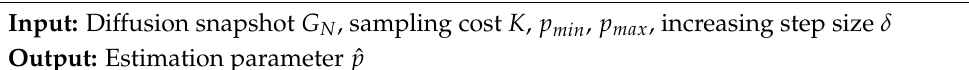
Algorithm 1 Decaying Parameter Estimation (DPE( K